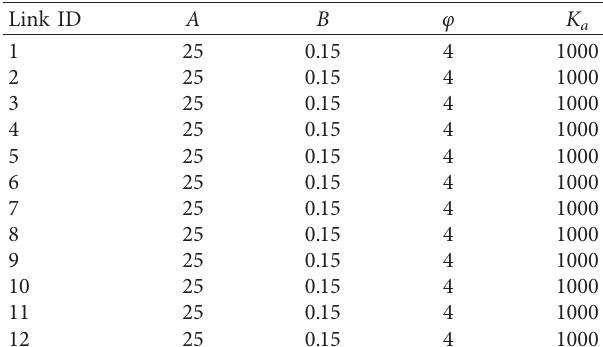
Figure 3: Signal control used in the intersection of the network. Table 3: Link parameters of the small